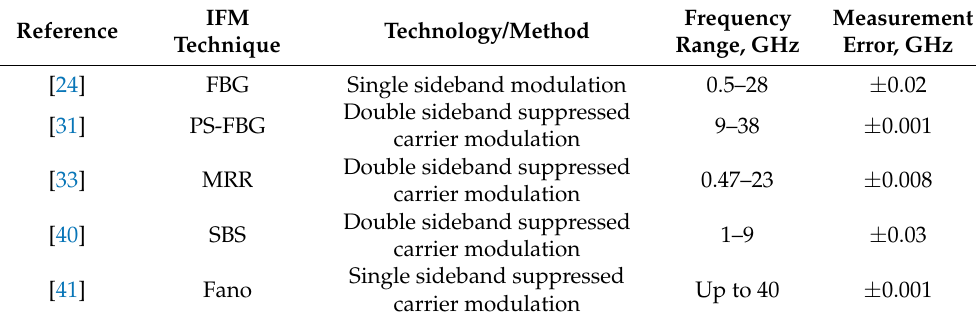
Table 7. Performance of techniques with the best characteristics presented in the considered IFM